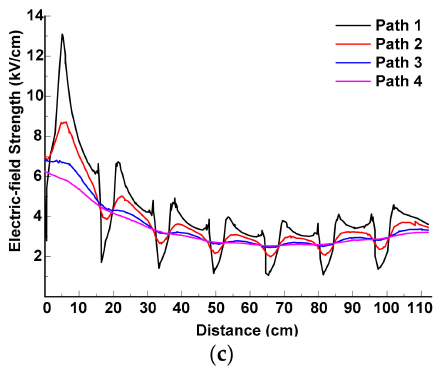
Figure 11. The electric field distribution of glass insulator in direction 1, 2, 3. ( a ) The electric field distribution in direction 1; ( b ) The electric field distribution in direction 2; ( c ) The electric field distribution in direction 3.